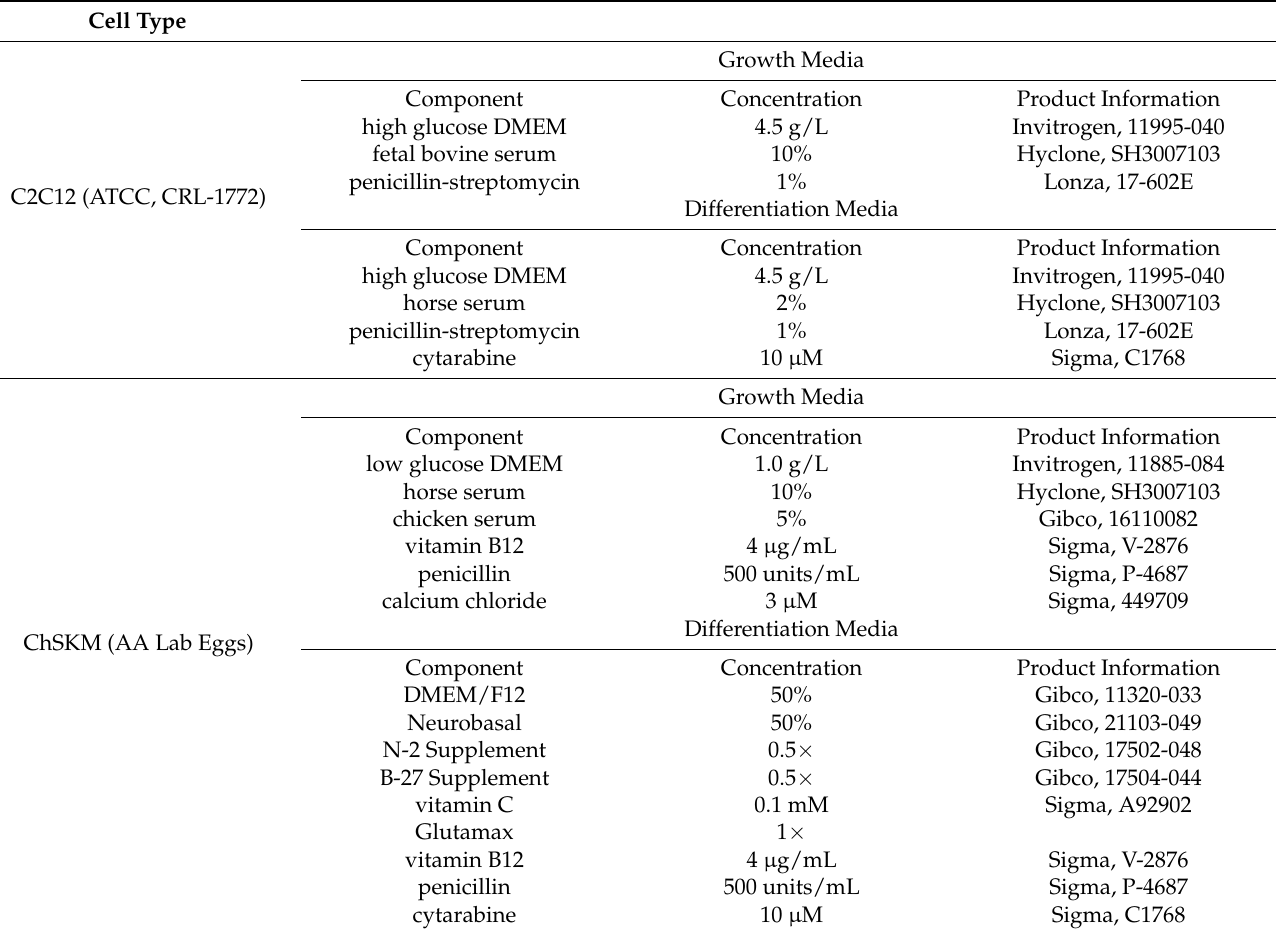
Table 1. Media components for C2C12 and chick